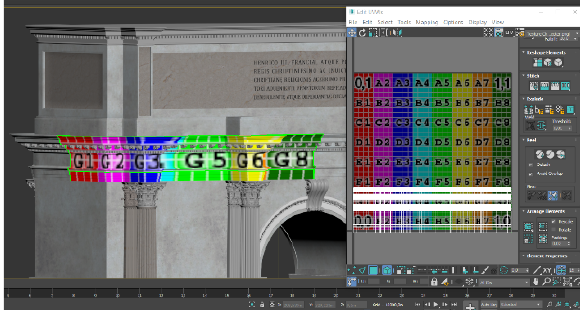
Figure 10. Texture mapping using the Unwrap UVW modifier not varying much from the painting that depicted them (figure 10).